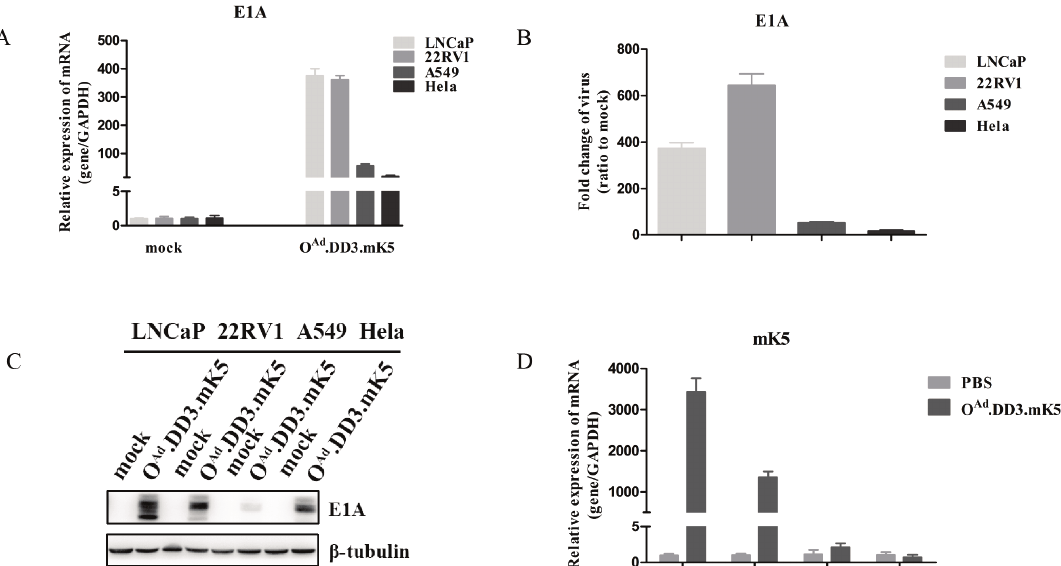
Figure 2: O Ad .DD3.mK5 largely replicated in PCa tumor cells. A. Analysis of E1A in LNCaP, 22RV1, A549 and Hela cell lines treated with O Ad . DD3.mK5 at an MOI of 5 for 48 hours by qRT-PCR. B. Date A are processed as the fold change relative to mock cells. C. Expression of E1A measured by western blot. D. The expression of the mk5 in four cancer cell lines LNCaP, 22RV1, A549 and Hela was detected using qRT-PCR. The qRT-PCR data were normalized to GAPDH RNA. All experiments were repeated three times. The bars represent the mean ± S.D (n =